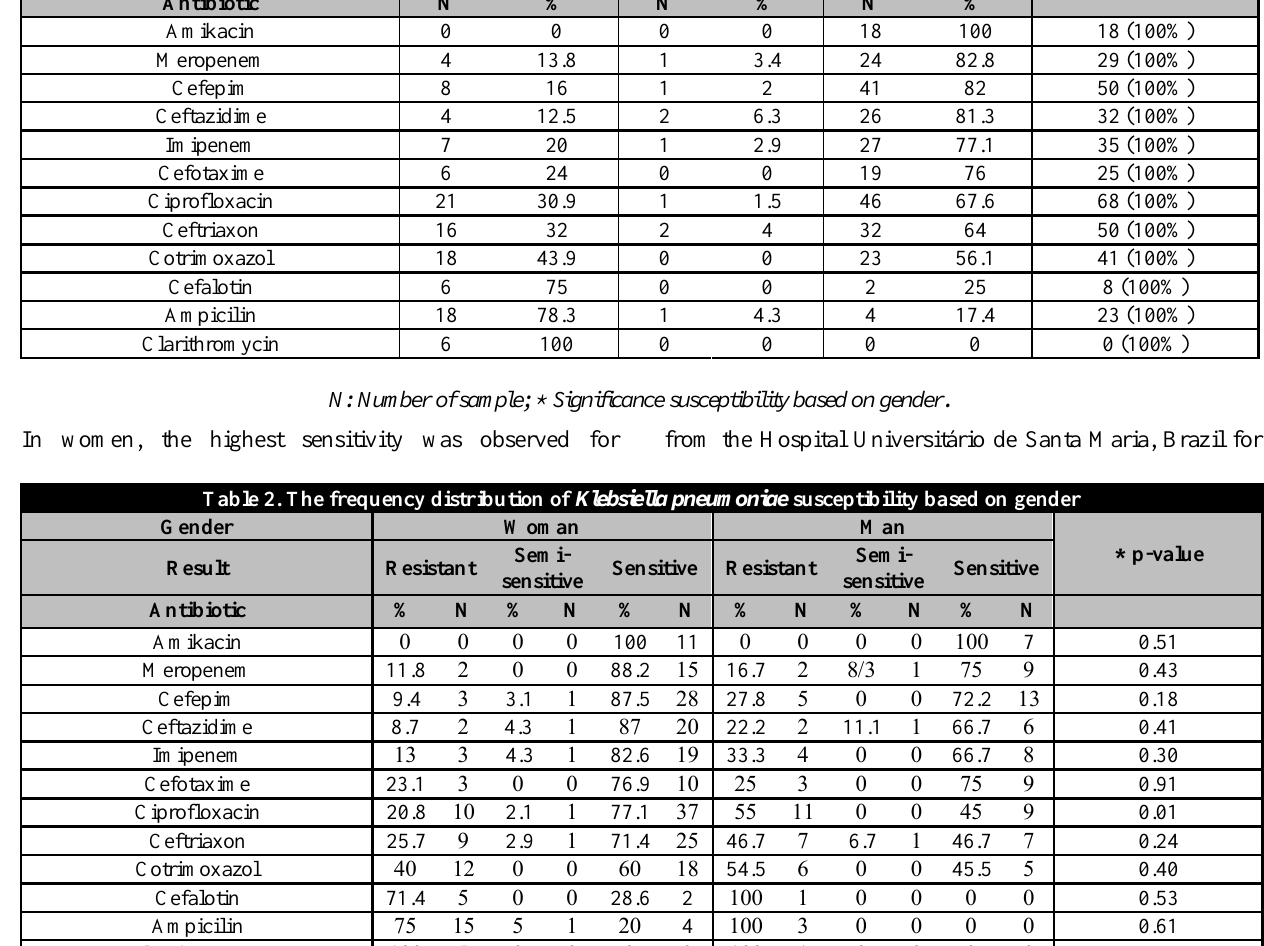
Table 1. The frequency distribution of Klebsiella pneumoniae susceptibility based on the type of antibiotic Resistant Semi-sensitive